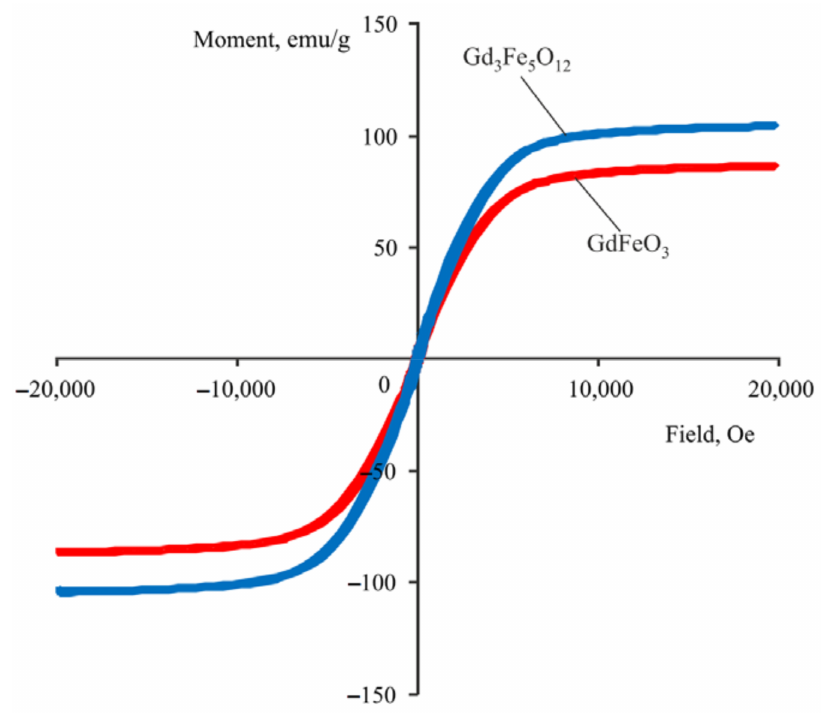
Figure 7. Magnetization reversal curves of GF/TPO NP samples. Table 3. Magnetic characteristics of